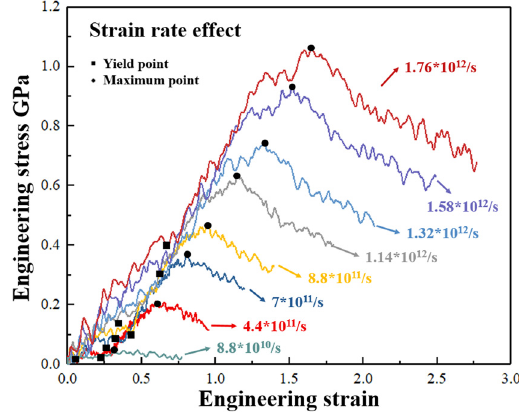
Figure 2: Stress – strain relations under dynamic tensions at dif - ferent strain